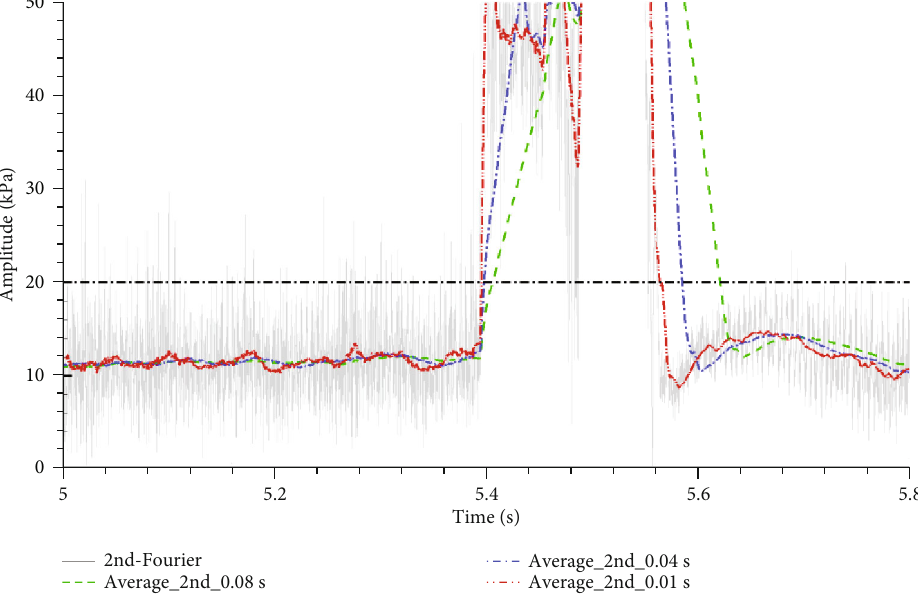
Figure 16: Second-order harmonic analysis results of the inlet static